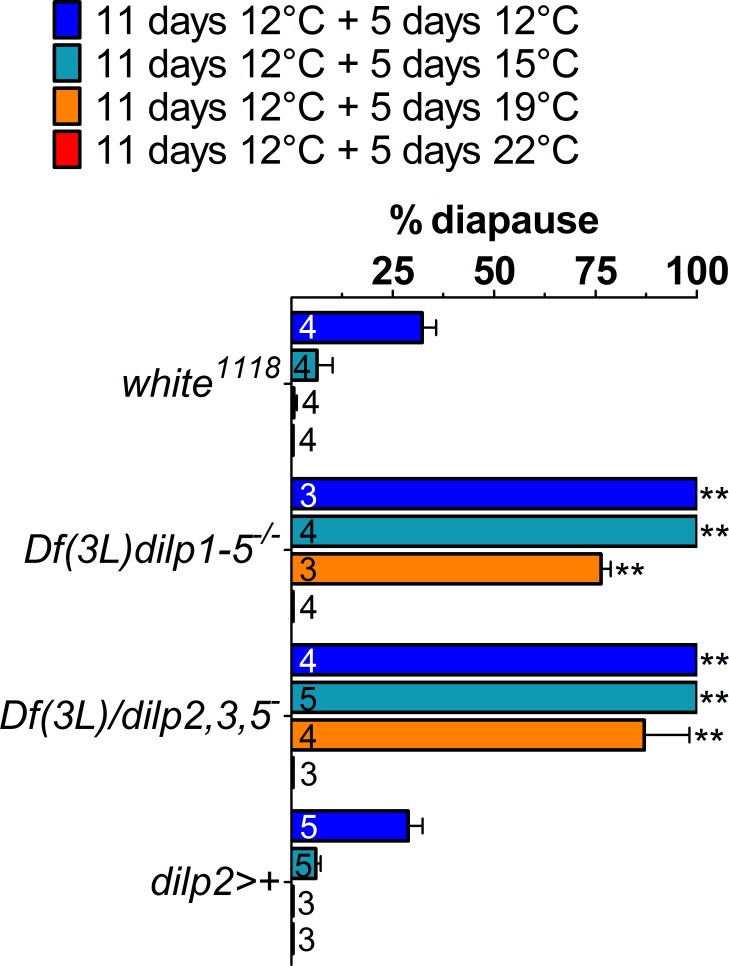
Combinations of dilp mutations maintain diapause under more favourable conditions.Under warmer temperatures and longer photoperiods (LD16:8), conditions favourable to growth, Df(3L)dilp1-5-/- and Df(3L)dilp1-5/dilp2,3,5- mutants remain in diapause at high levels even at 19°C compared to controls, but ovaries mature at 23°C. Mean ± SD, ANOVA on arcsin transformations, **p<0.01.